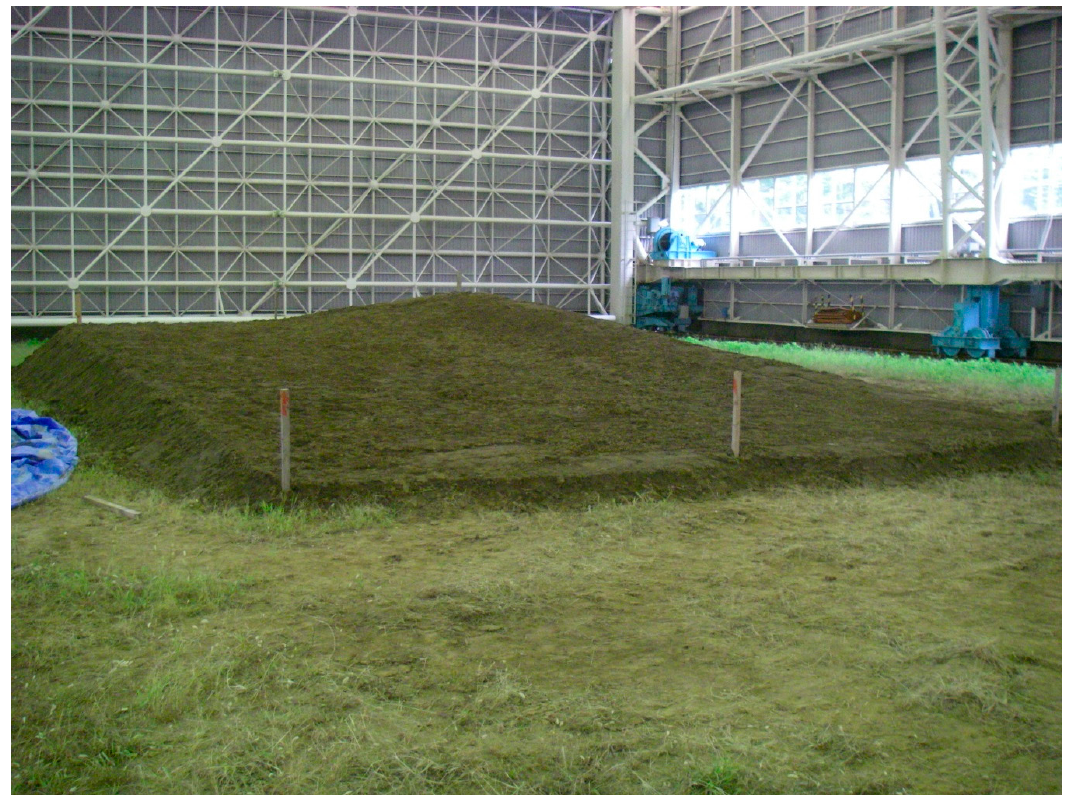
Figure 1. The experimental plot shown under construction in 2009.